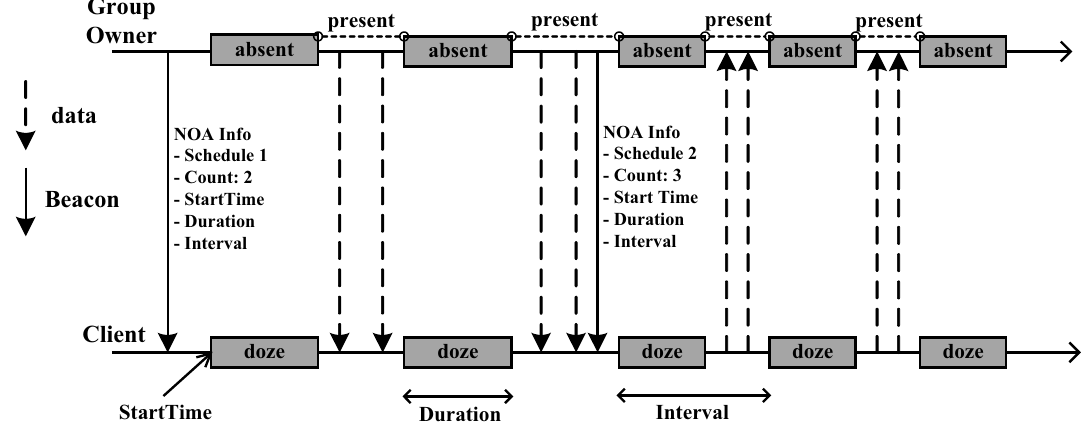
Figure 2. Notice of absence power-saving in Wi-Fi